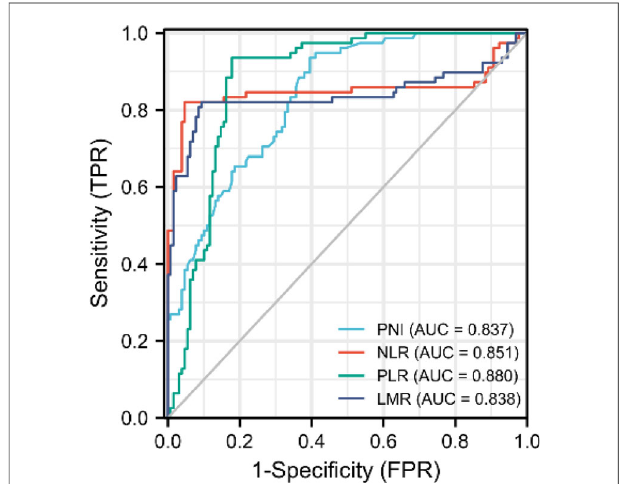
FIGURE 1 | Roc curves of PNI, NLR, PLR and LMR. PNI, prognostic nutritional index; NLR, neutrophil-to-lymphocyte ratio; PLR, platelet-to- lymphocyte ratio; LMR,